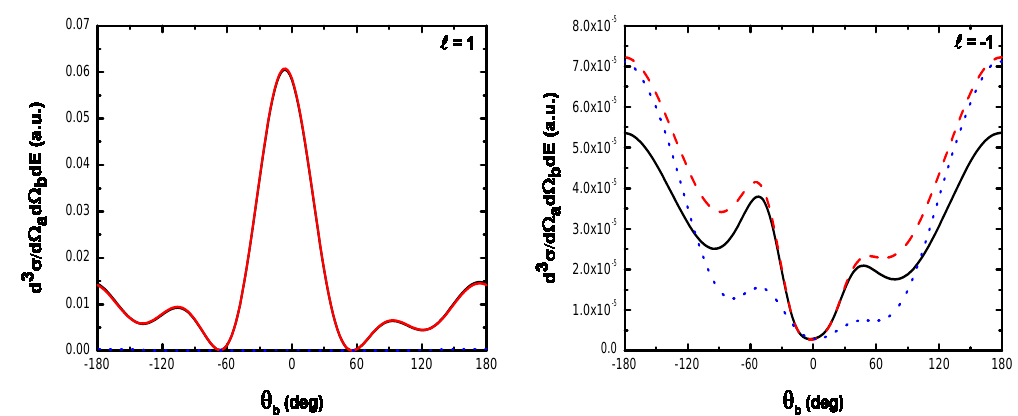
Figure 16. Same as Figure 14, but with the laser frequency ω = 6.42